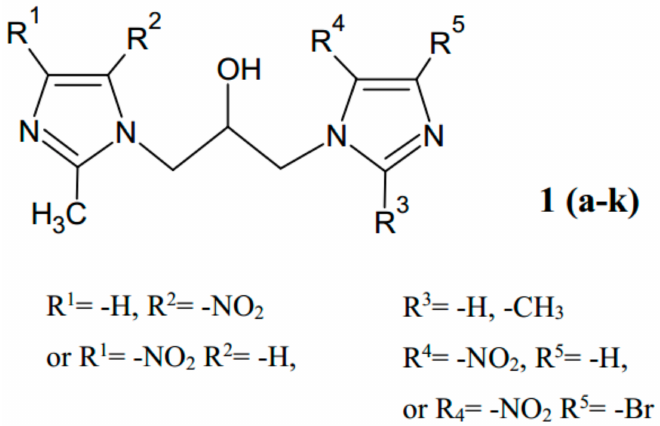
Figure 1. The structure of hydroxyisopropyl-linked